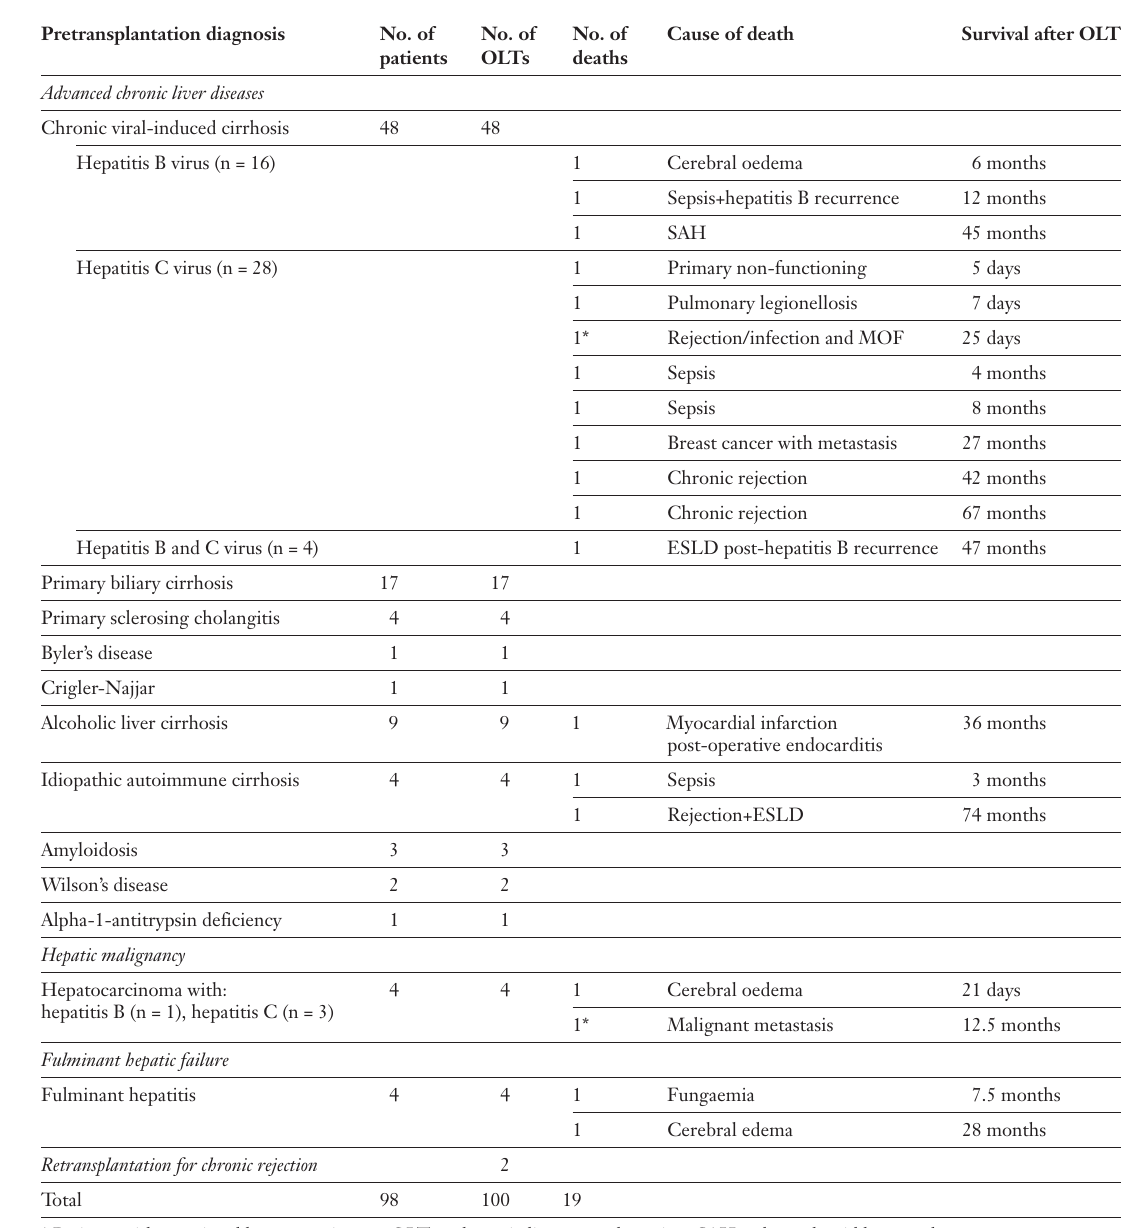
Pretransplantation diagnosis No. of Table 1